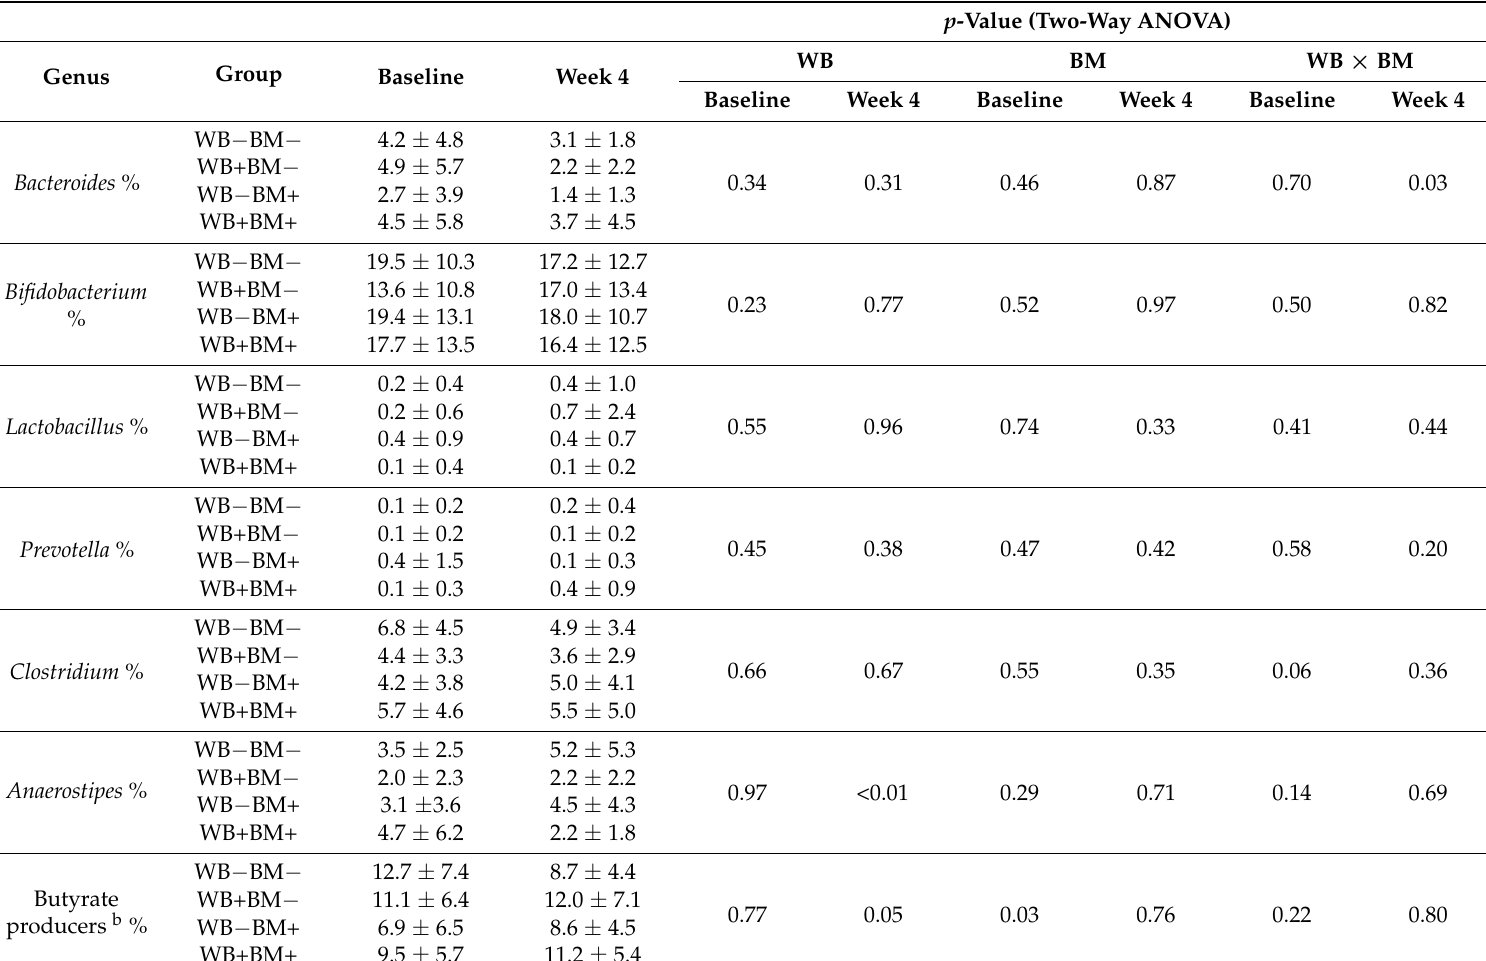
Table 6. Relative abundances of selected bacteria genera in fecal samples obtained at baseline and week 4. a